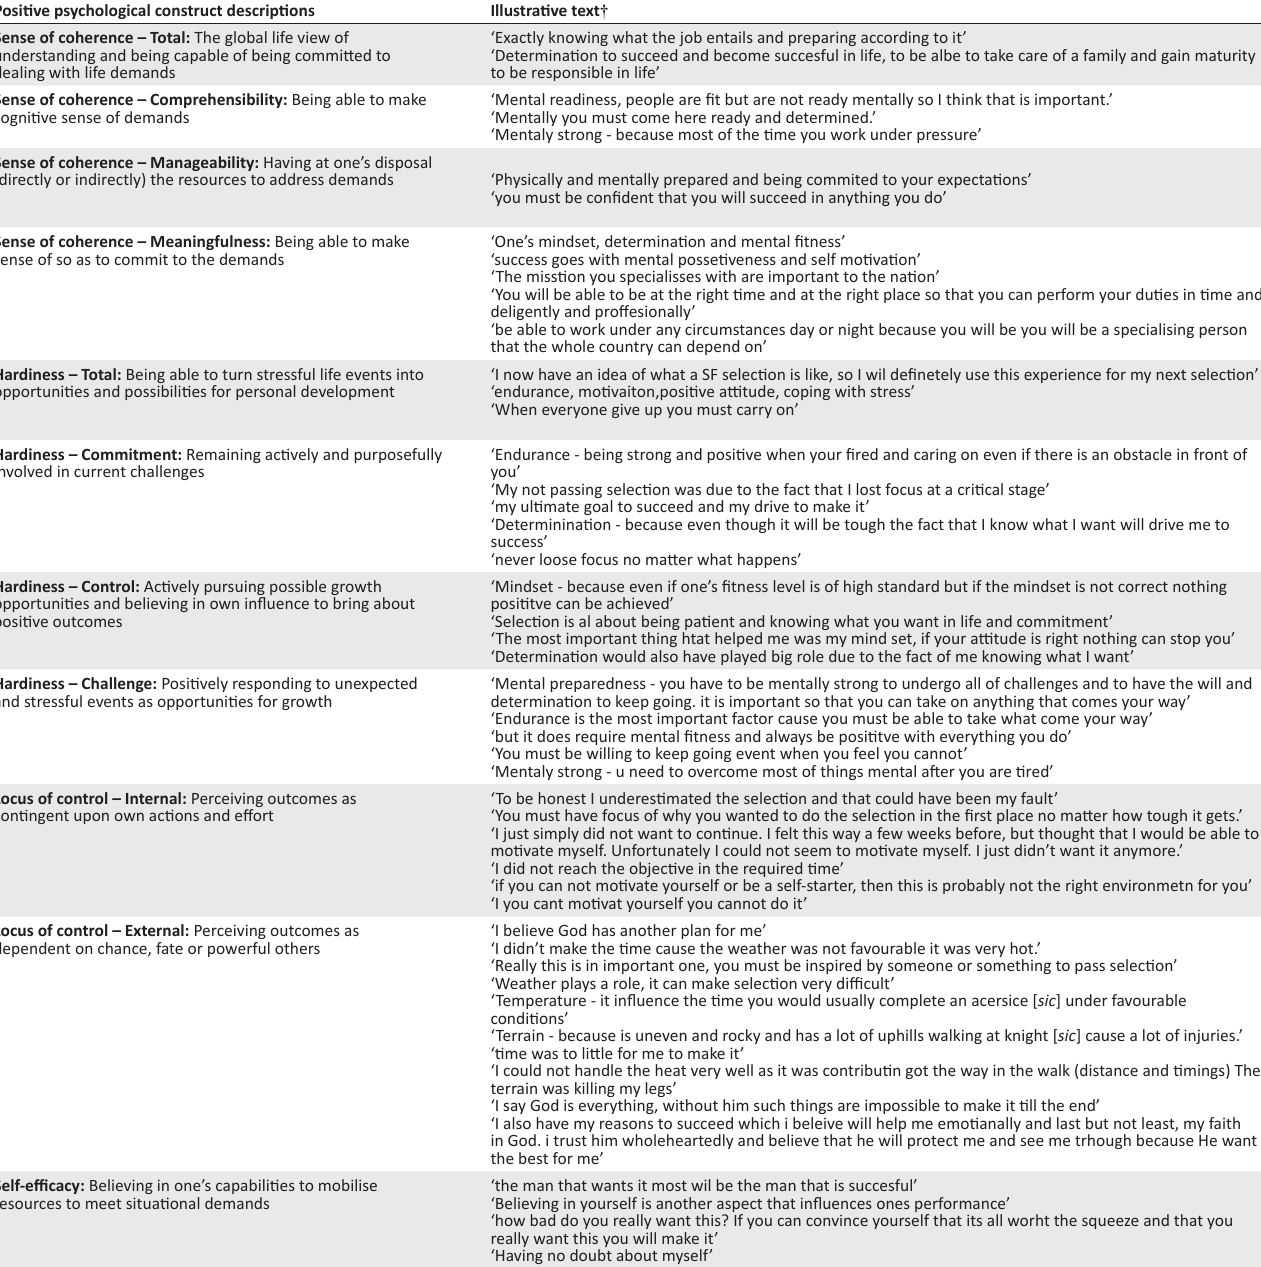
TABLE 3: Thematic content analysis mapping onto the quantitatively measured